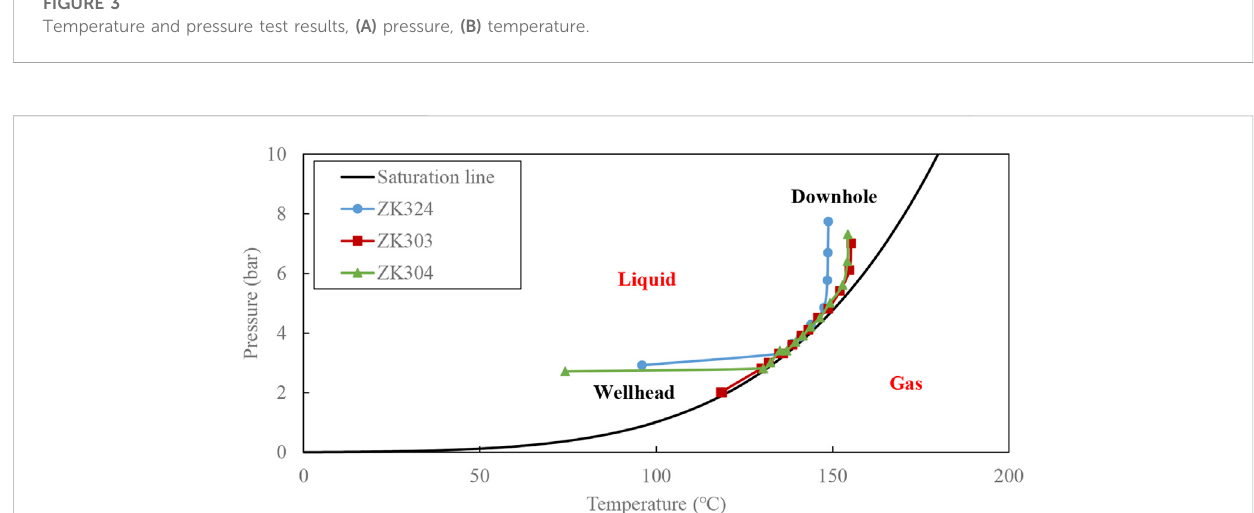
FIGURE 4 Phase behavior along wellbore under dynamic test